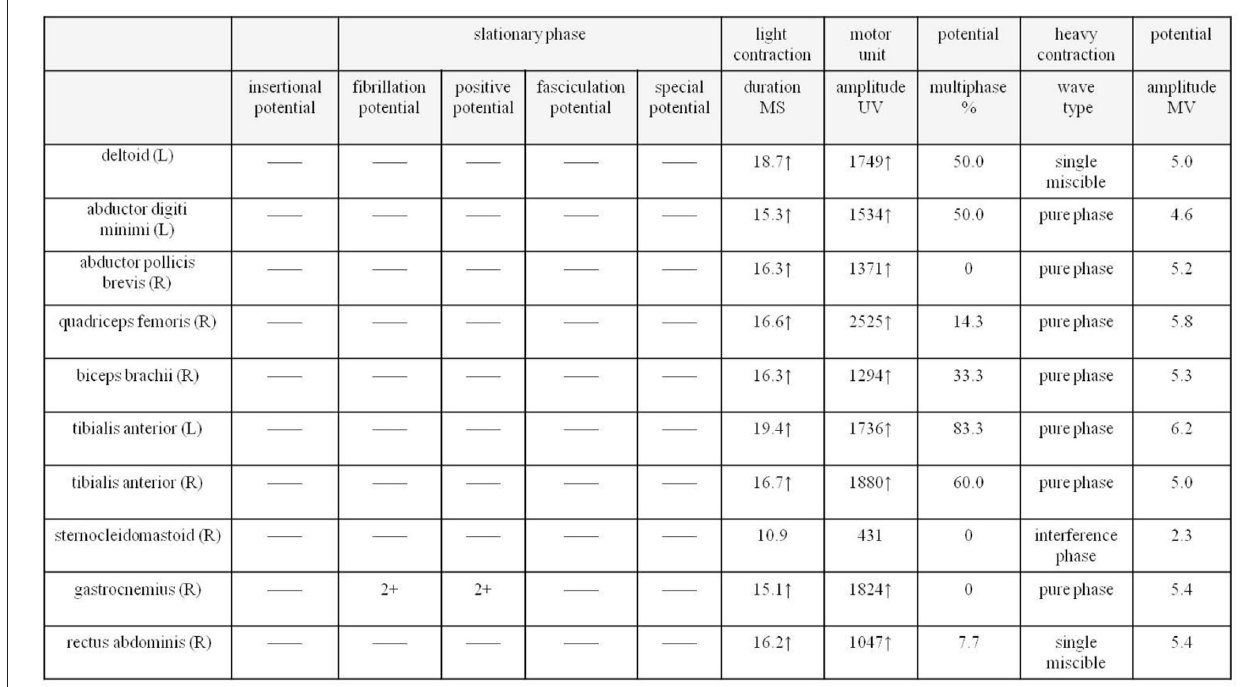
ultrasound revealed thickened and rough gallbladder wall and multiple high echoes in the inner wall of the gallbladder, thus polyps and inflammatory changes were mostly